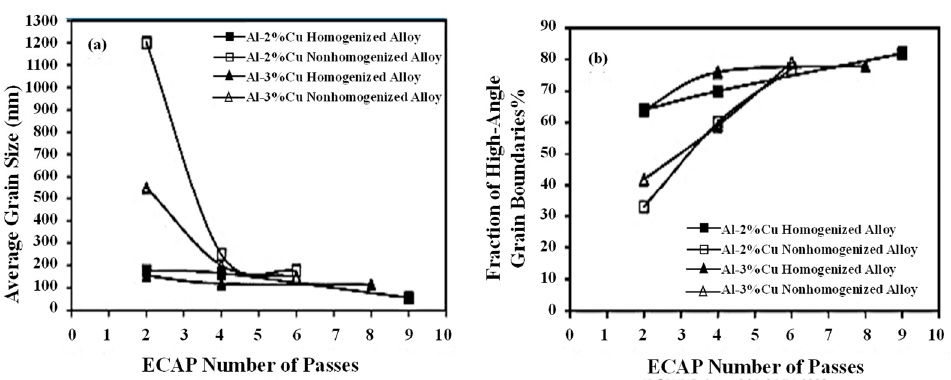
Figure 14. ( a ) shows the average grain size of the alloy as a function of the pass, and ( b ) shows the high angle grain boundary ratio of the alloy as a function of the pass [95]. Reproduced with permission from Elsevier B.V.